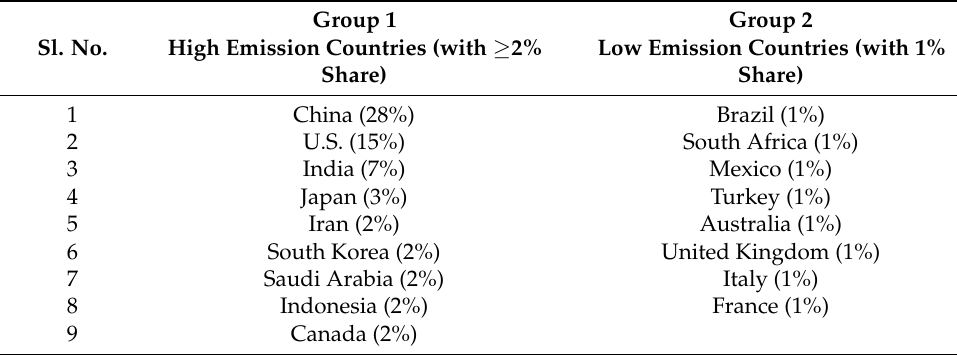
Table 1. High and Low emission